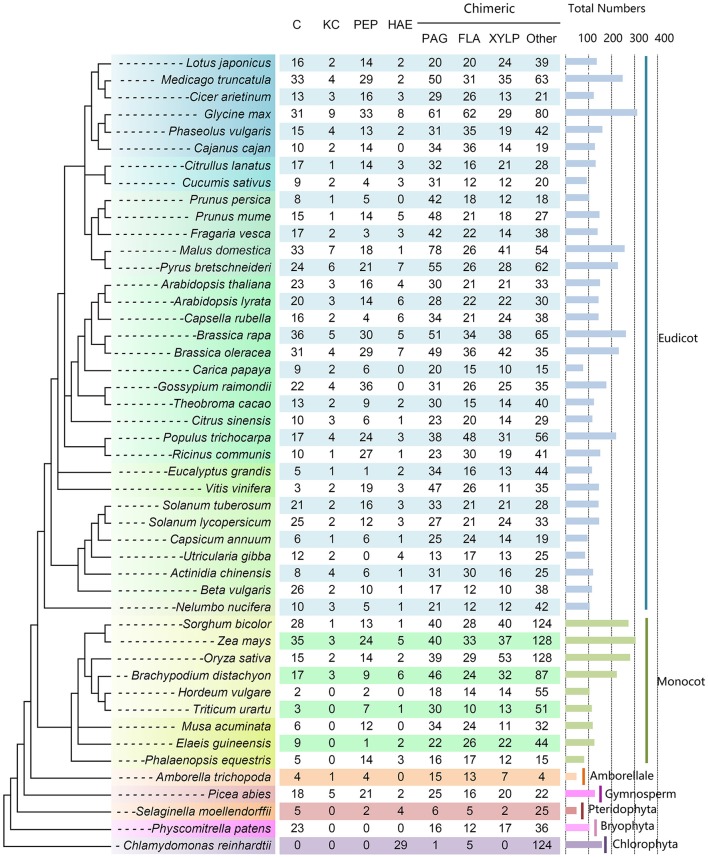
Distribution of AGP genes across different plant lineages. The copy number of each AGP subfamily is indicated at the top. The species tree was constructed based on the three representations of the species in Phytozome (https://phytozome.jgi.doe.gov/pz/portal.html) and then referred to the taxonomy tree in NCBI (http://www.ncbi.nlm.nih.gov/guide/taxonomy/). The horizontal bar indicates the total number of AGP genes in each plant species.